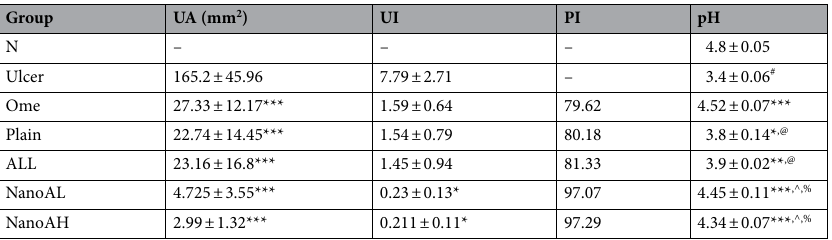
Table 5. Gastric AA evaluation parameters against ethanol-induced gastric injury in rats. Data are expressed as mean ± SEM, # p < 0.001 compared to N group, * p < 0.05 compared to ulcer group; ** p < 0.01 compared to ulcer group; *** p < 0.001 compared to ulcer group; @ p < 0.001 compared to ulcer group; ^ p < 0.01 compared to plain group; % p < 0.05 compared to ALL group.